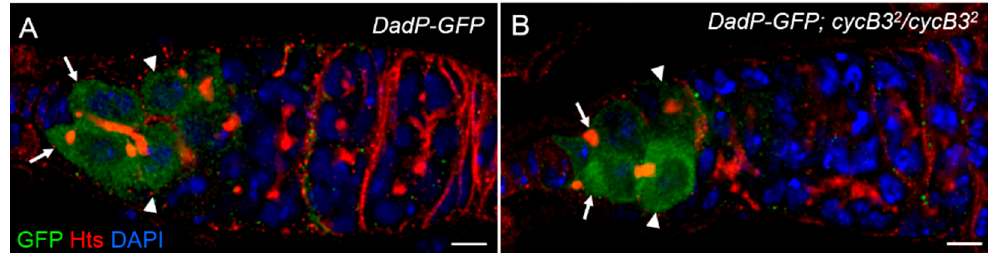
Figure 4. cycB3 doesn’t affect Dad expression pattern. ( A , B ) Ovaries were stained with anti-GFP (green), anti-Hts (red) antibodies and DAPI (blue). GSCs are indicated by arrows, CBs are noted by arrowheads. Germaria from both Dad-GFP ( A ) and Dad-GFP ; cycB3 2 / cycB3 2 ( B ) exhibited a higher GFP expression level in GSCs, and a lower level in CBs. Five-day-old flies were analyzed. Scale bars: 5 μ m.